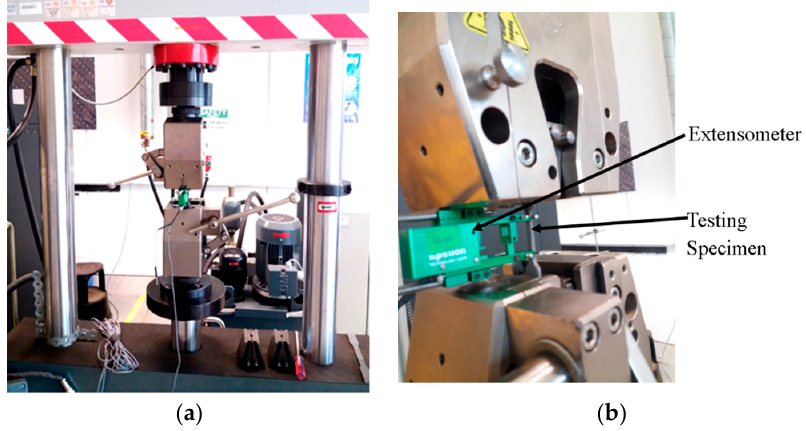
Figure 7. ( a ) Tensile test machine and ( b ) sample fitted in the machine.